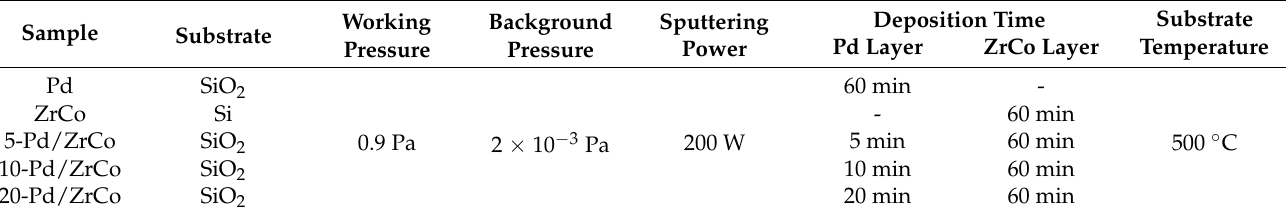
Table 1. Sputtering parameters of the Pd, ZrCo, and Pd/ZrCo